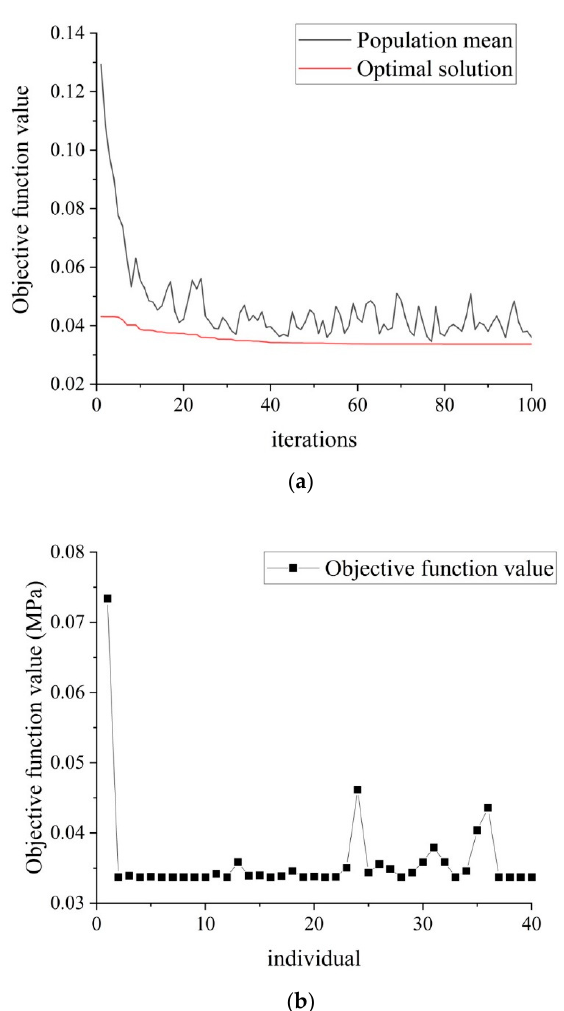
Figure 12. Objective function values of ( a ) iterations and ( b ) individuals. Appl. Sci. 2019 , 9 , x FOR PEER REVIEW